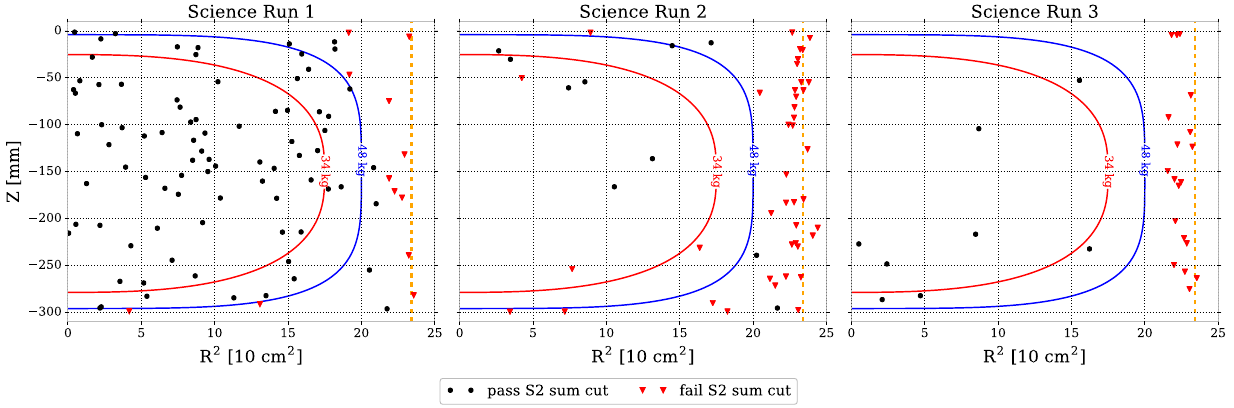
Fig. 5 Observed event distributions for all three SRs. Displayed in black are events passing all cuts. Shown in red are those events that pass all selection cuts except for the condition on the S2 sum. See text